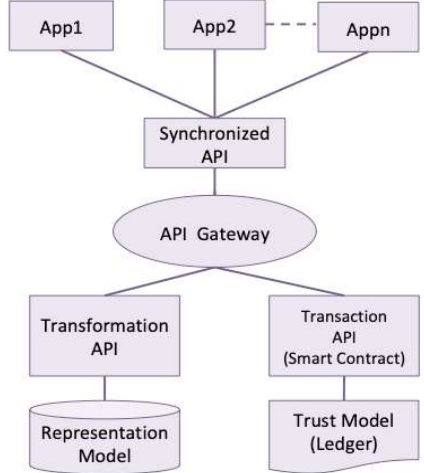
Figure 3. Synchronized API and API gateway.